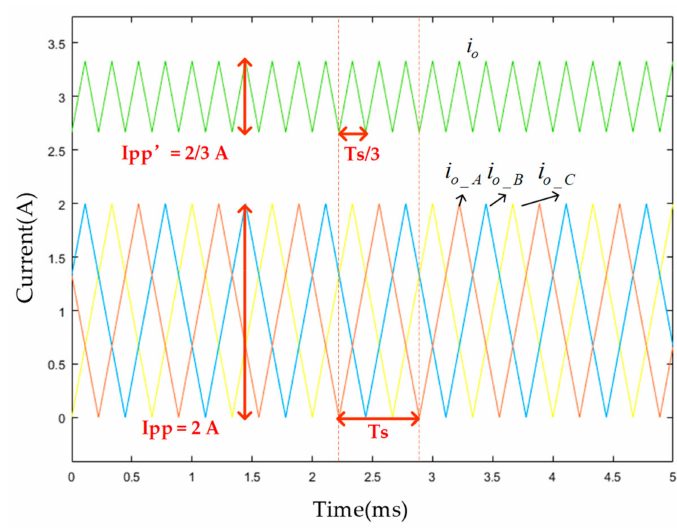
Figure 7. Relationships among phase currents and port output current in DC mode.